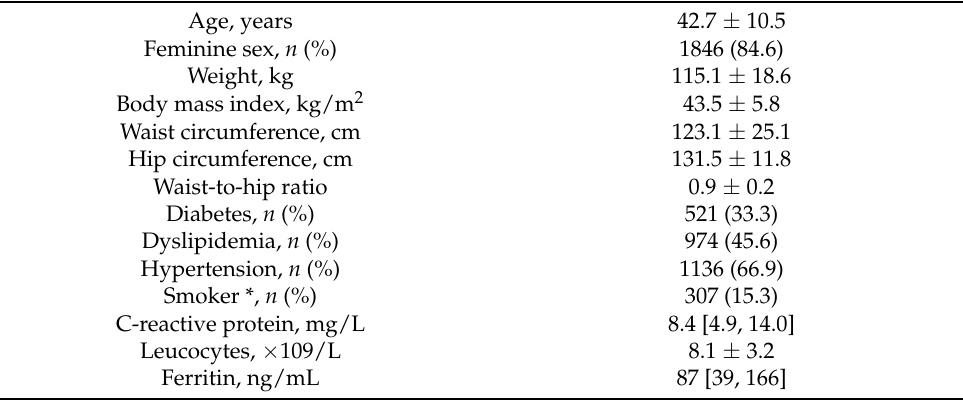
Table 1. Clinical and demographic characteristics of the population included ( n =